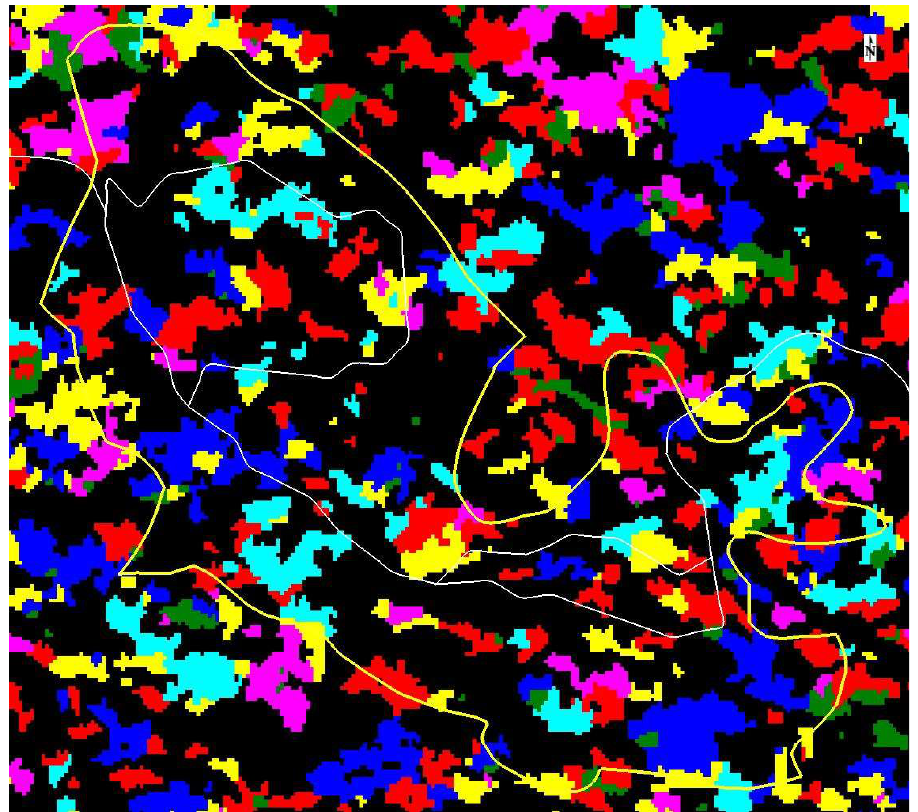
Figure 8. The output of Classification 2 using custom rule-sets for each species. Legend: C. elastica —green, C. odorata —blue, C. alliodora —red, P. macroloba —yellow, P. sp. A —teal, S. microstachyum — magenta.